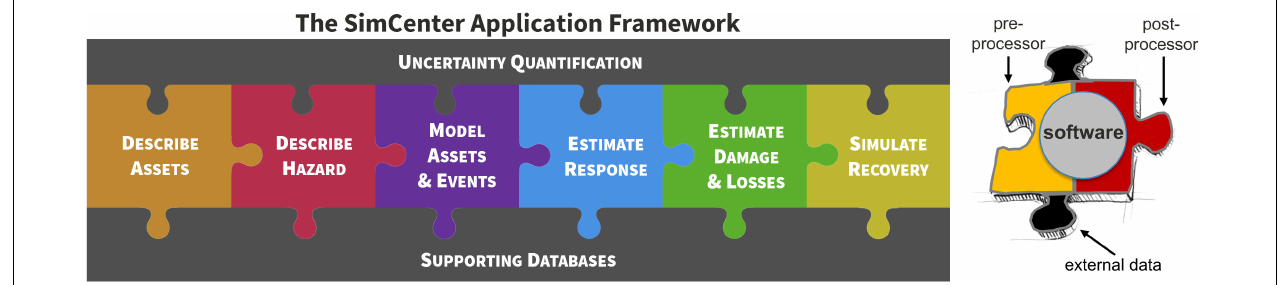
FIGURE 2 | Modules of the software application framework developed by the